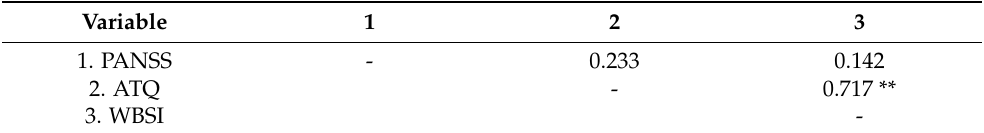
Table 4. Zero-order correlations between the variables in the study for Individuals with Sub- stance/Medication Induced Psychotic Disorder